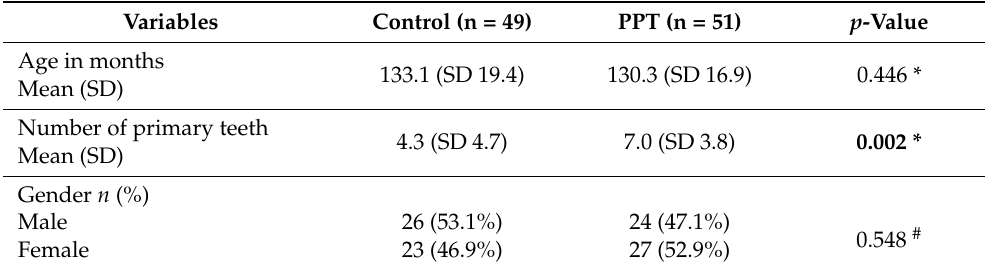
Table 2. Characteristics and comparisons of groups.